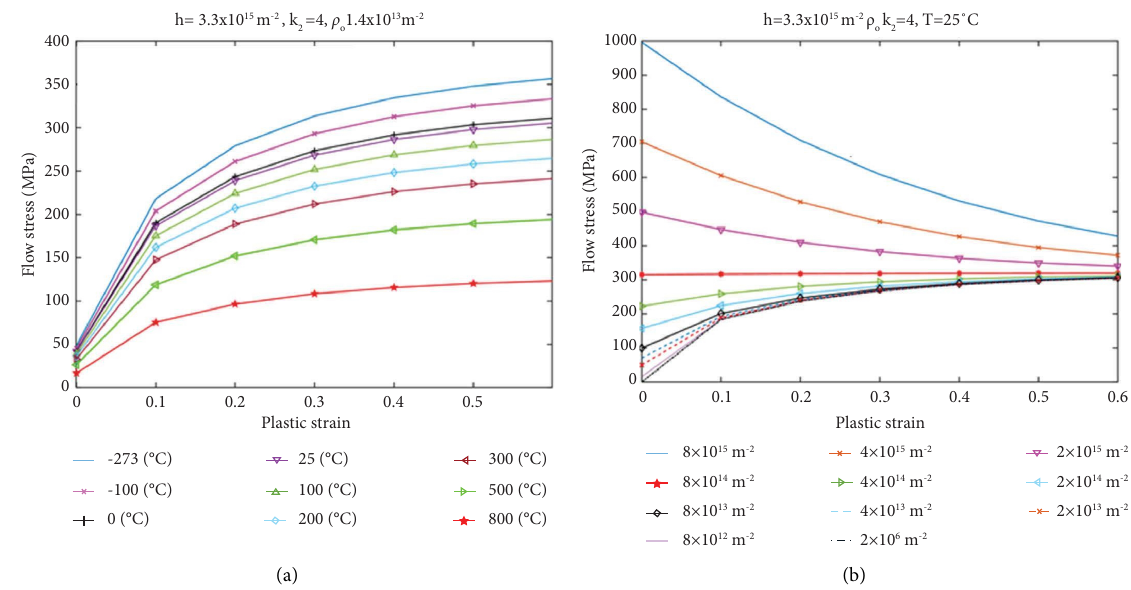
Figure 6: Te efects of (a) temperature and (b) the initial dislocation density on the shape of the fow stress